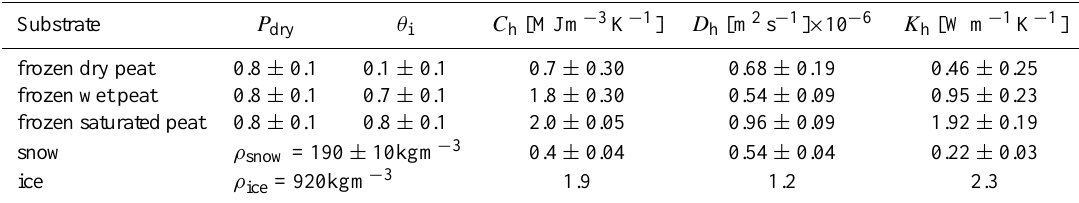
Table 1. Used soil parameters for ground heat flux calculations during the winter period. Values of porosity P dry and volumetric ice content θ i are estimated based on soil sample analysis and in situ soil water content measurements during summer. The heat capacities are calculated by weighting C h , i and C h , s according to the assumed ice content and porosity. The thermal diffusivities D h are determined by using the conductive method, from which we evaluate the thermal conductivity K h with estimated heat capacity (cf. Langer et al., 2011). Errors are calculated using Gaussian error